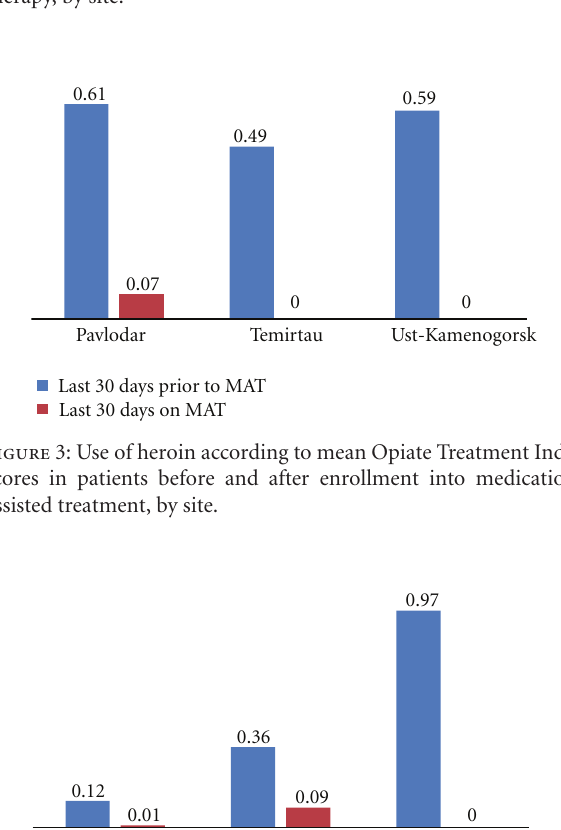
Figure 2: Level of satisfaction with one’s own health status in the last 30 days before and after enrollment in medication-assisted therapy, by site.